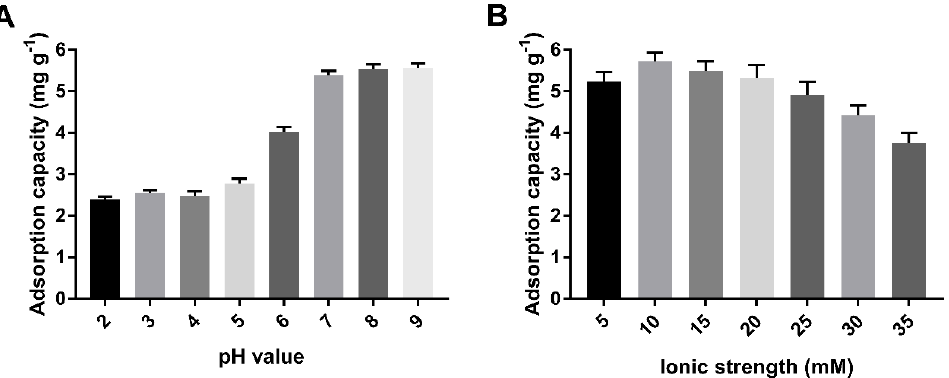
Figure 6. Optimization of adsorption conditions of pH ( A ) and ionic strength ( B